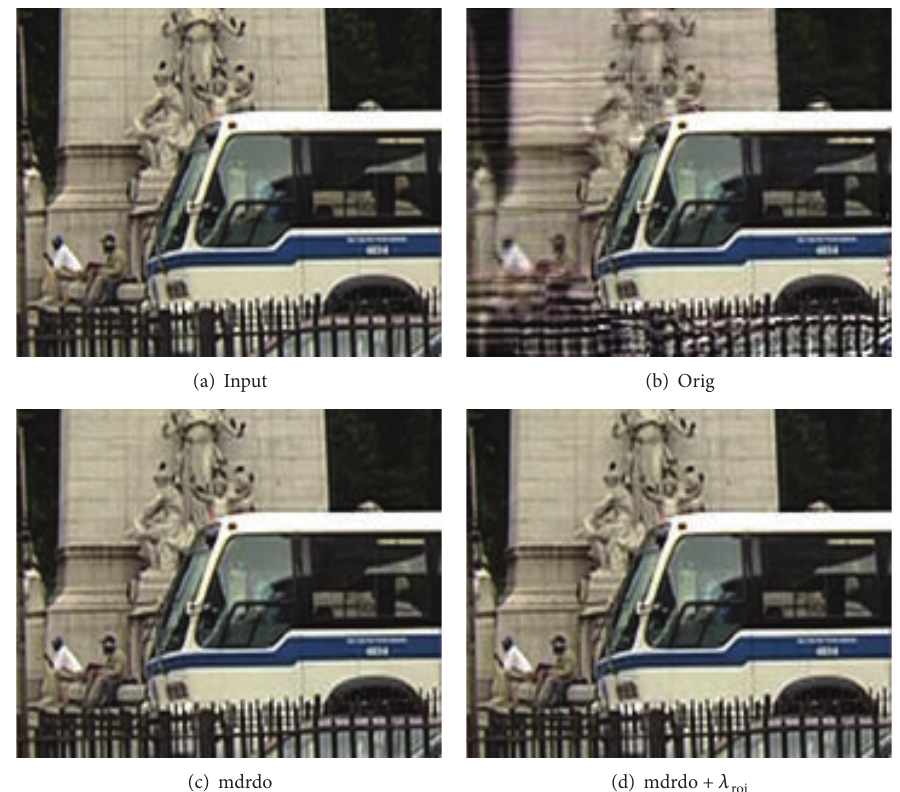
Figure 12: Visual quality comparison under “Dec ROI” scenario for the “bus”